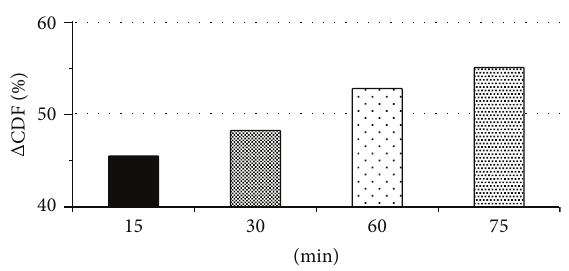
Figure 9: Δ CDF for different delays of the SBO.